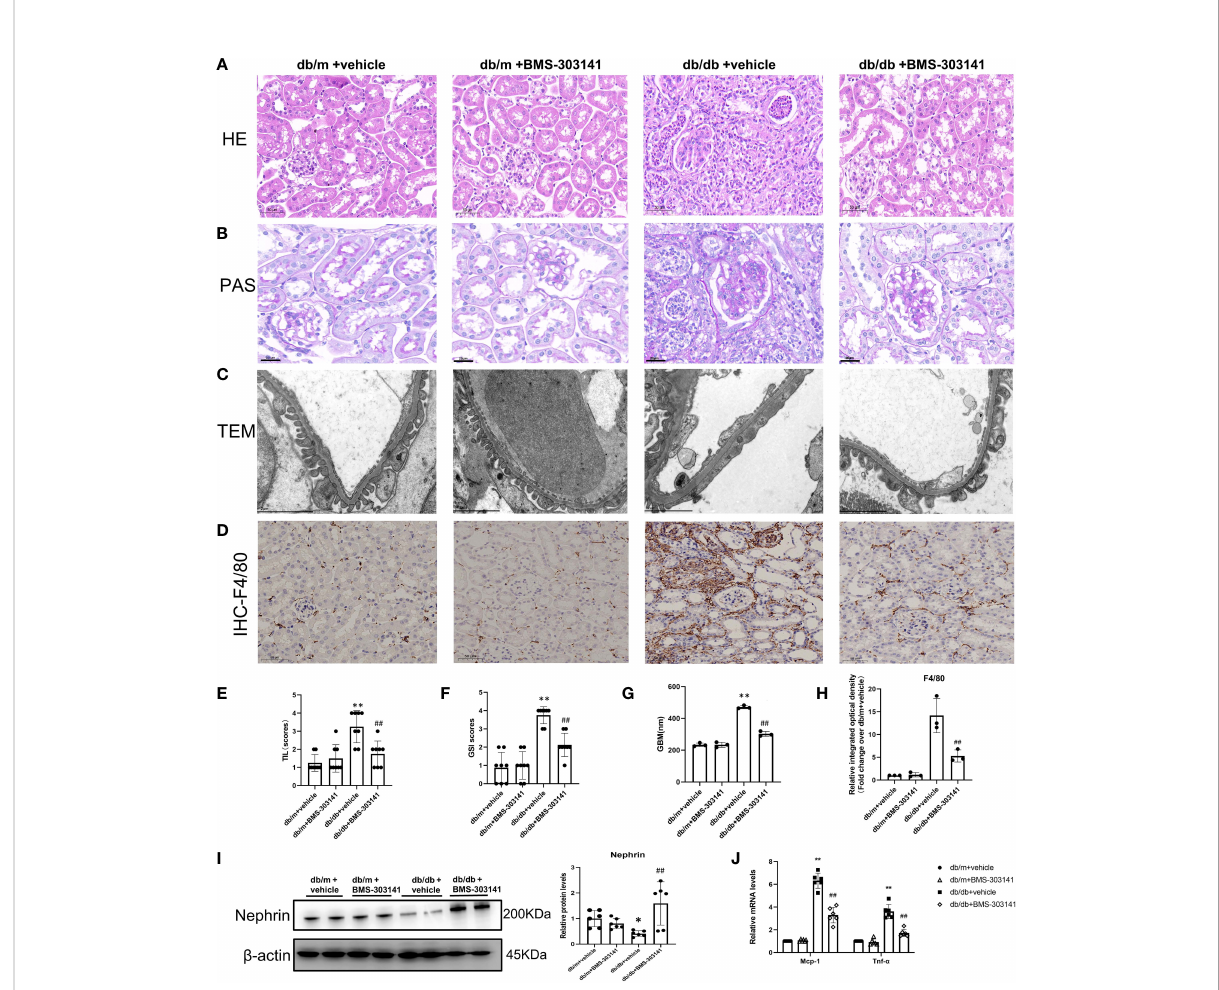
FIGURE 5 Impact of BMS-303141 on renal histologic injuries. (A) Representative H&E staining of kidney cortex sections (magni fi ed 200x) from db/m and db/db mice for 16 weeks; (B) Periodic acid-Schiff (PAS)-stained kidney cortex sections (magni fi cation 200x) from db/m and db/db mice at the end of 16 weeks; (C) Transmission electron microscopic evaluation of the glomerular fi ltration barrier of db/m and db/db mice (magni fi cation 7000x), which indicates areas of podocyte foot-process effacement; (D) Representative photomicrographs (magni fi cation 200x) illustrating the in fi ltration of F4/80-positive macrophages in the tissues of the kidneys of mice in various groups; (E, F) tubulointerstitial injuries and the level of glomerulosclerosis index were evaluated semiquantitatively as per the Materials and methods section. *P < 0.05, **P < 0.01 versus db/m + vehicle group; #P < 0.05, ##P < 0.01 versus db/db + vehicle group, n = 8 per each group; (G) GBM, glomerular basement membrane, and thickness in db/m and db/db mice at the end of 16 weeks. **P < 0.01 versus db/m + vehicle group; ##P < 0.01 versus db/db + vehicle group, n = 3 per each group; (H) Semiquantitative immunohistochemical evaluation of the F4/80 in fl ammation-associated protein expression in various groups. ##P < 0.01 versus db/db + vehicle group, n = 3 per each group; (I) Western blots and densitometric quantitation of the indicated protein of the renal damage marker, nephrin, in the kidney cortex from db/m and db/db mice; *P < 0.05 versus db/m + vehicle; ##P < 0.01 versus db/db + vehicle group, n = 6 per each group; (J) Quantitative real-time PCR analysis of Mcp-1 , Tnf- a transcripts in the kidney cortex of db/m and db/db mice, *P < 0.05, **P < 0.01 versus db/m + vehicle; #P < 0.05, ##P < 0.01 versus db/db + vehicle group, n = 6 per each group. The mean ± SD is represented by each bar in the four independent